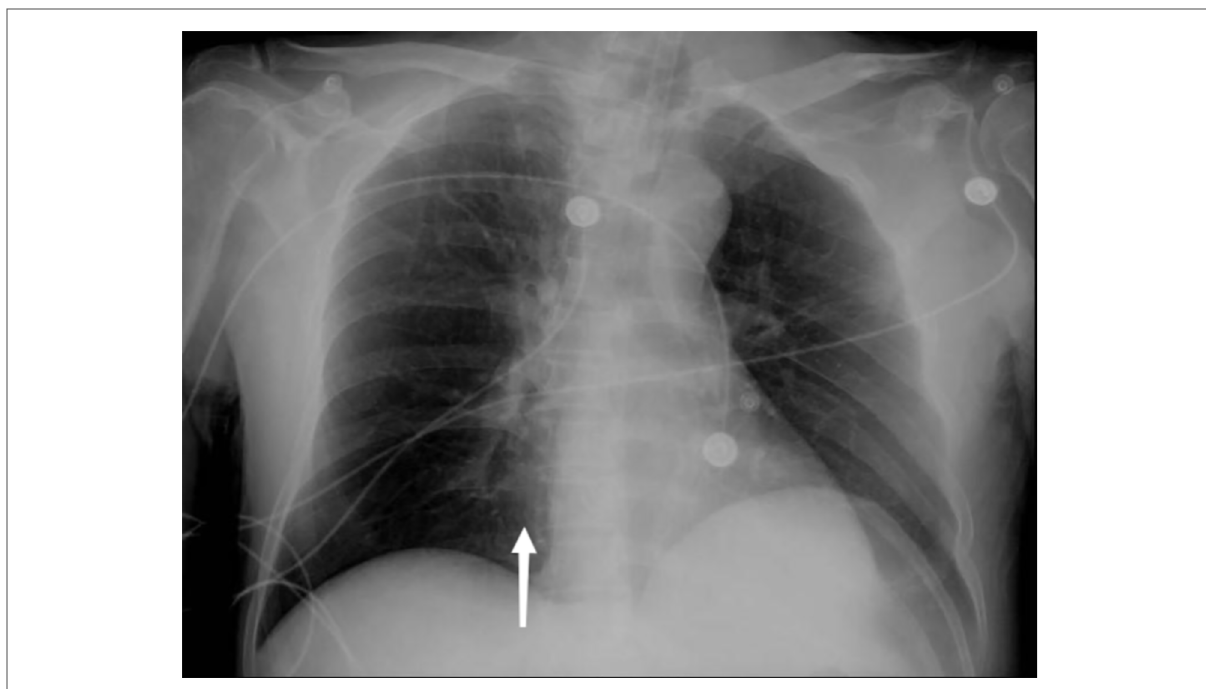
FIGURE 2 The patient ’ s pulmonary visual fi eld brightness increased, and the right ventricular margin was extremely dilated. The right ventricular lucency increased, and there was a honeycomb-like change in the right ventricle. The pulmonary artery was occupied by air, and the pulmonary artery margin was dilated, and the pulmonary artery lucency signi fi cantly